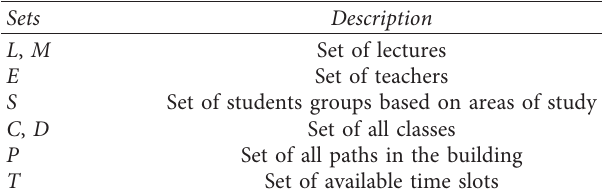
Table 2: Sets of the model.